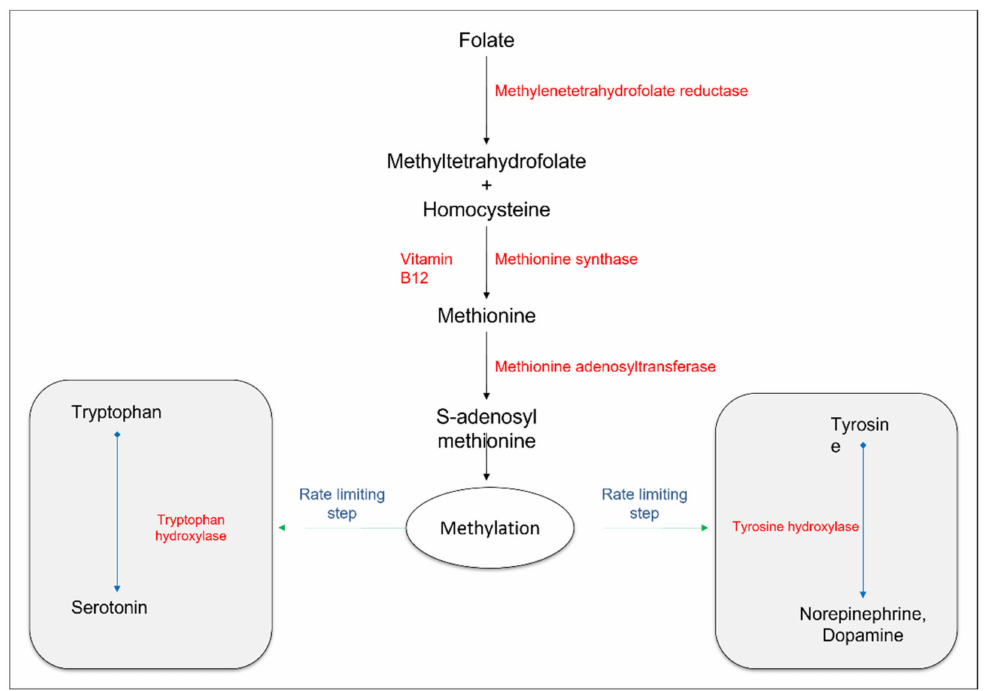
Figure 2. Biochemical synthesis of SAMe and its potential role in the synthesis of neurotransmitters. SAMe is synthesized in the body through a series of biochemical reactions involving folate, vitamin B12, and certain enzymes. SAMe acts as a methyl-donating cofactor in the rate-limiting steps of the chemical reactions, leading to the synthesis of serotonin, norepinephrine, and